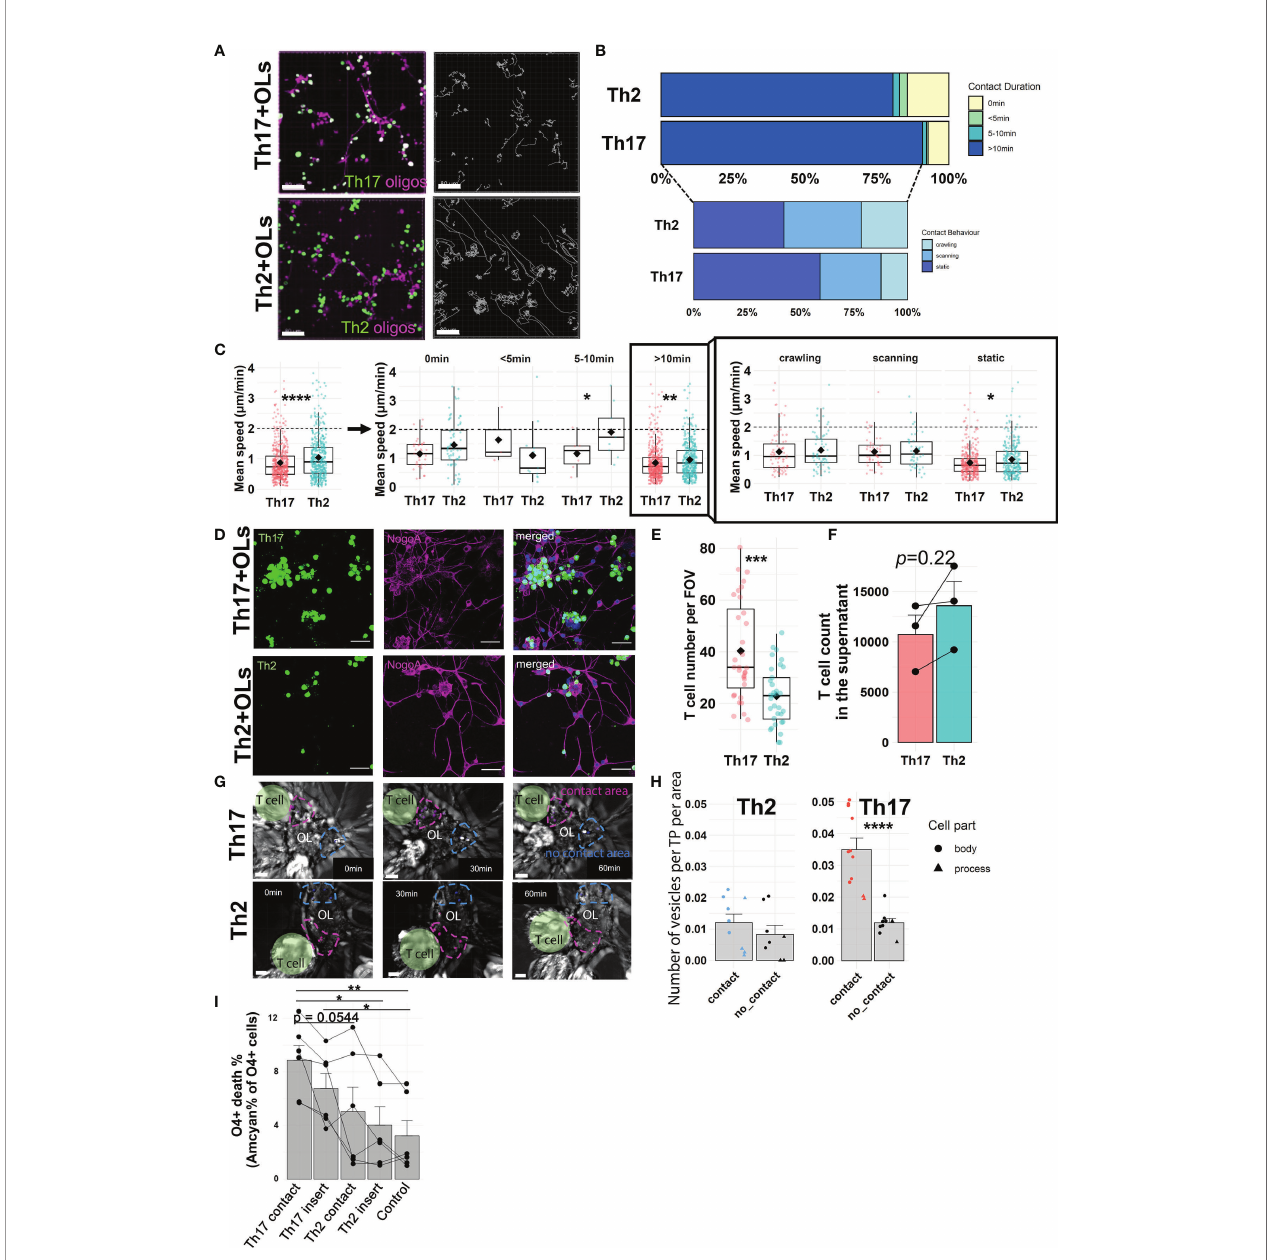
FIGURE 1 | Active interactions of Th17-polarized cells with human primary OLs. (A) Representative images (left) and tracks (right, gray lines) of human Th2- or Th17-polarized cells (green) in coculture during 2 h with human OLs in primary culture (magenta), scale bar = 80 m m. (B) Proportion of T cells according to duration of contact with OLs (upper panel: no contact, < 5 min, 5 – 10 min or > 10 min) and contact behavior among T cells displaying a >10-min contact (lower panel: scanning, crawling, static). (C) Mean speed of polarized T cells in coculture with primary human OLs according to contact duration (left panel) and contact behavior (right panel) among T cells displaying >10-min contacts. Wilcoxon rank-sum test. (A – C) n = 4 different OL preps and 4 T cell donors, n = 526 cells (Th17-polarized) and 485 cells (Th2-polarized), 30-min observation periods. One dot represents one cell, diamond = mean. (D) Representative images and (E) quanti fi cation of adherent human Th2- or Th17-polarized cells (green) after 4 h in coculture with human OLs (magenta) in primary culture (scale bar = 40 m m). Wilcoxon test, n = 4 different OL preps and 4 T cell donors, diamond = mean. (F) Number of non-adherent T cells as measured by fl ow cytometry using AccuCount beads. Paired t-test, p = 0.22. n = 2 OL preps, n = 3 T cell donors. (G) Representative images and (H) quanti fi cation of vesicle-like structures per timepoint (TP) in areas of primary human OLs in contact (magenta) or not (blue) with human Th2- or Th17-polarized cells (vesicle number/TP/µm 2 ). T cells are highlighted in green, areas of interest are delimited by dashed line, and vesicle-like structures are pointed by spots (contact in magenta, no contact in blue), n = 3 OL preps and 3 T cell donors, paired t-test. (I) Quanti fi cation of human primary OL death after 16 h of direct coculture with polarized T cells (contact) or separated by a permeable membrane (insert) at a 1:2.5 ratio. Control condition = no T cells. Each dot represents one donor, n = 6 different OL preps and 6 T cell donors, one way ANOVA with Tukey ’ s post hoc test. *p < 0.05, **p < 0.01, ***p < 0.001, ****p <